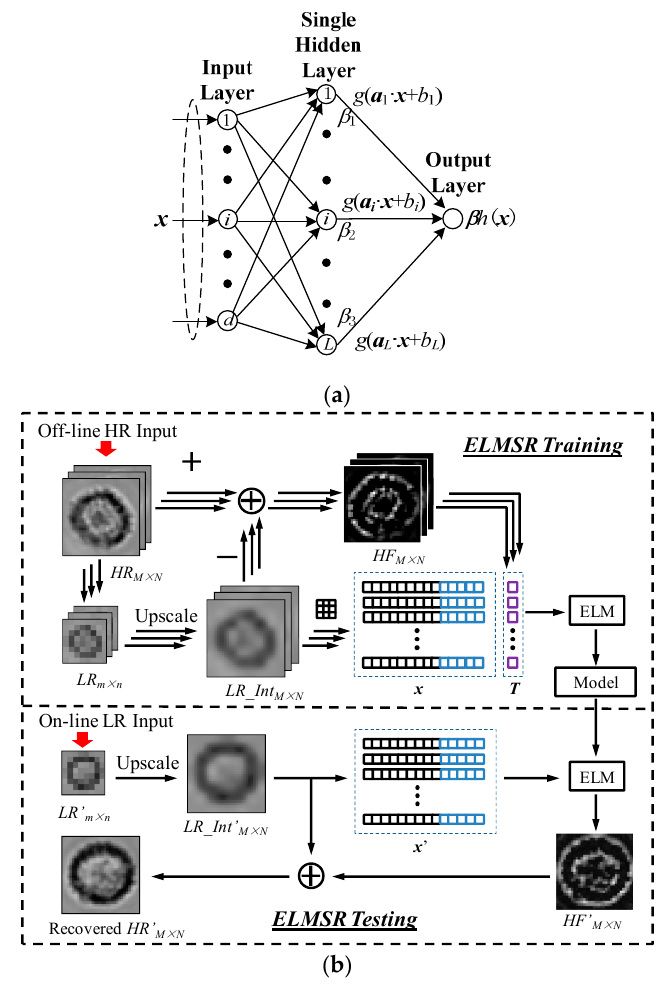
Figure 4. ( a ) Extreme learning machine (ELM) model structure; and ( b ) extreme learning machine based super-resolution (ELMSR) processing flow including one off-line training and one on-line testing step.